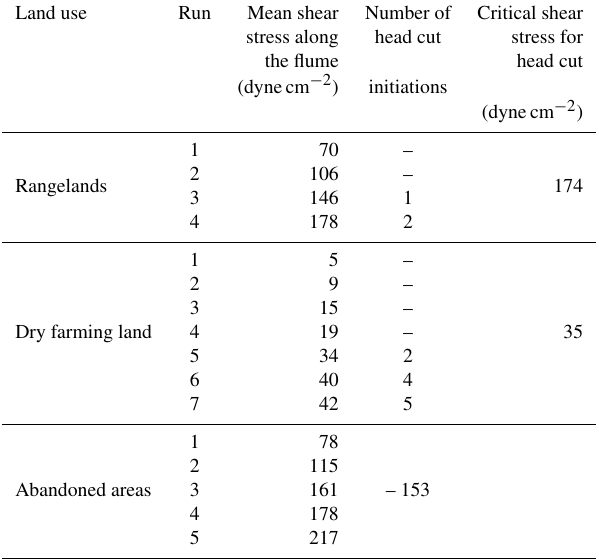
Table 2. Shear stress for different runs with observed head cuts for each land use (1Pa = 10dynecm − 2